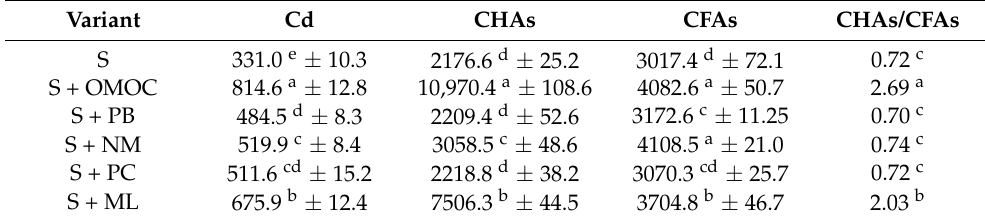
Table 4. Mean content of carbon (mg kg − 1 ) in the humus fraction. Variant Cd CHAs CFAs CHAs/CFAs S 331.0 e ±